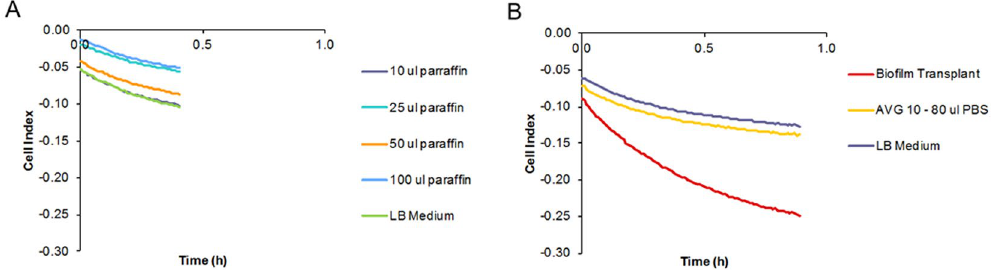
Figure 3. Effect of the addition of biofilm and control substances on top of the bacterial broth on single- frequency impedance. ( A ) Impedance curves following addition of paraffin in different amounts (n = 4). ( B ) Impedance curves following addition of PA14 pellicle biofilm (n = 4) or different amounts of PBS buffer (n = 1). As the curves for PBS buffer additions had identical shapes, an average curve is shown. n indicates the number of technical